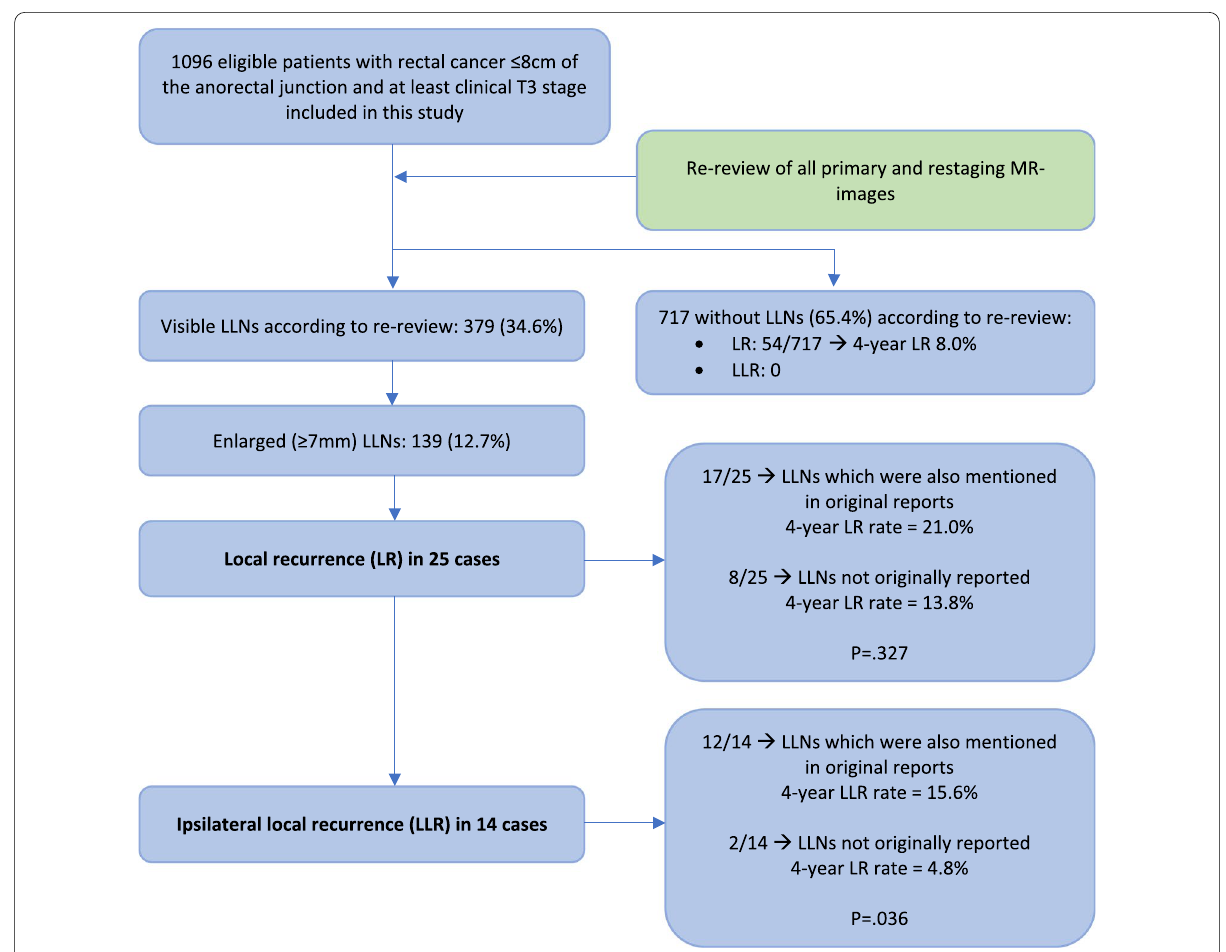
Fig. 6 Flowchart of long‑term oncological